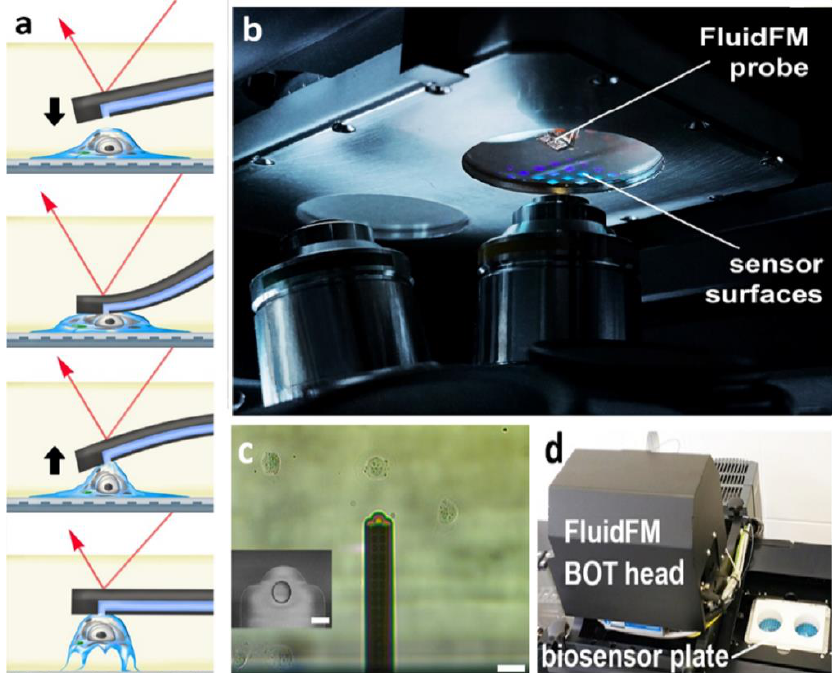
Figure 20. Principle of the robotic fluidic force microscopy (FluidFM BOT) measurements. ( a ) The workflow of the cell adhesion strength measurement using the FluidFM method. The hollow cantilever is approached the adhered cell (top frame). Upon contact, a vacuum is applied to fix the top of the cell to the cantilever (middle frame). Once a stable connection is established, the cantilever is retracted while its bending is recorded by the reflected laser beam deflection (red arrow). ( b ) The custom-made biosensor insert holder positioned in the sample holder of the FluidFM BOT device. The photograph is made from below, showing the objectives of the inverted microscope of the FluidFM BOT, the two circular wells, the sensor surfaces (reflective coloured squares in the right well) and the probe on the upper side of the sensor insert. ( c ) Live view image of the fluidic force microscopy measurement: the picture shows the cantilever (and the purple laser spot on it) with surrounding adhered cells (scale bar: 40 µ m). Inset: scanning electron microscopy image of the top of the cantilever. The aperture with an 8 µ m diameter can be seen. Scale bar: 8 µ m (Image provided by Cytosurge AG). ( d ) Photograph showing the FluidFM BOT device on an anti-vibration table. The stage is fixed on an inverted microscope with the head unit above the objective. The inserted biosensor plate is seen at the right. (Reproduced with permission from [24] under Creative Commons Attribution 4.0 International